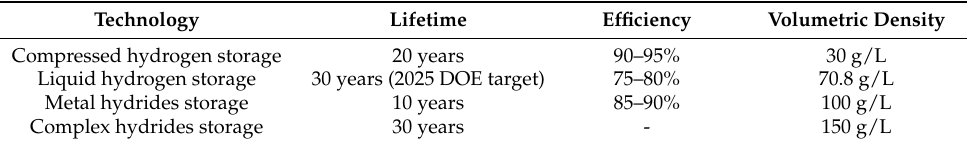
Table 11. Summary of technical parameters of commercial hydrogen storage technologies.